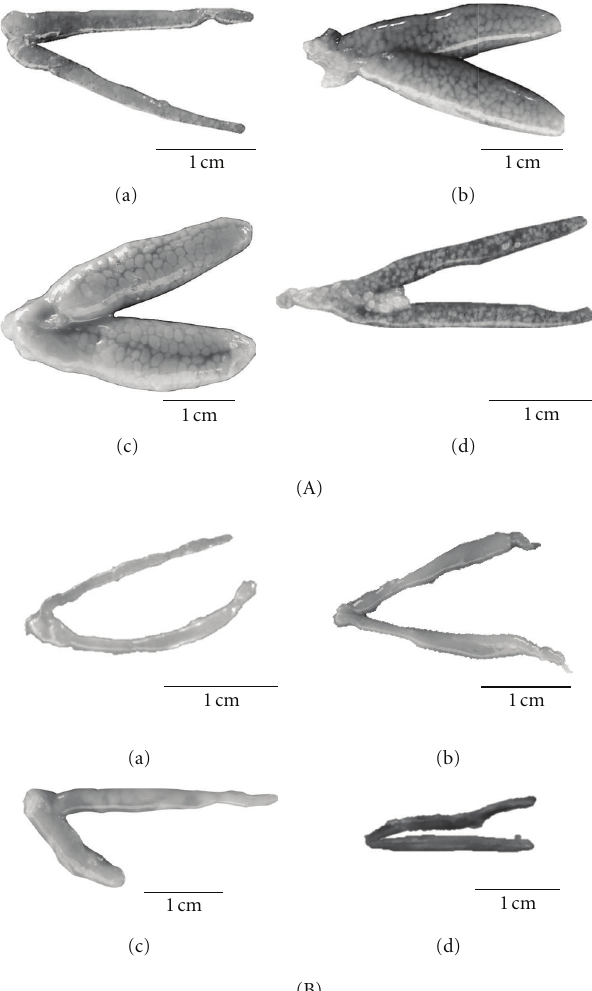
Figure 3: (A) Maturity stages of ovaries. (B) Maturity stages of testicles of C. menezesi : (a) immature; (b) maturing; (c) mature; (d) partially spent (scale = 1